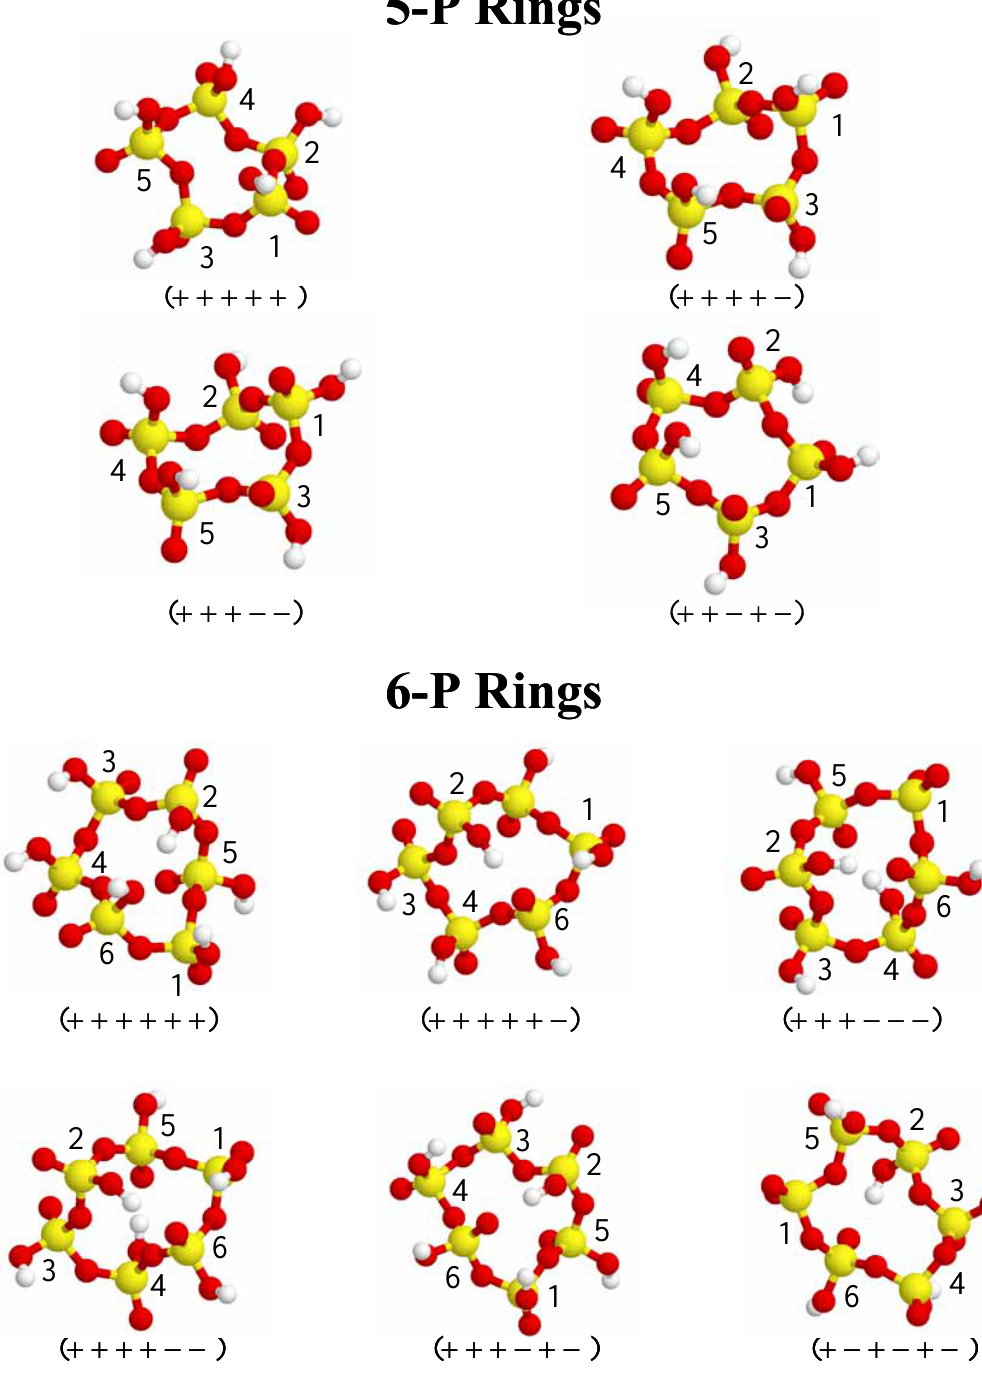
Figure 3. Different conformations for 5-P and 6-P-membered cyclic clusters investigated. Phosphorus is depicted as yellow, oxygen is red, and hydrogen is white. The +/ − nomenclature refers to the relative orientation of the terminal P=O bonds (see text for details). Each phosphorus nuclei has a number ID for identification with 31 P CSA tensor values in Tables 3 and